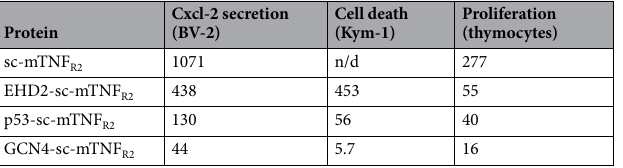
Cxcl-2 secretion (BV-2)